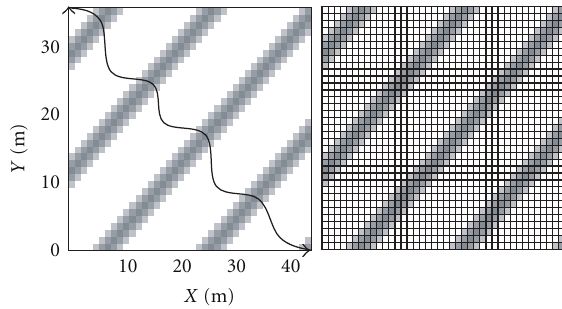
Figure 2: Wave simulation and occupancy grid.